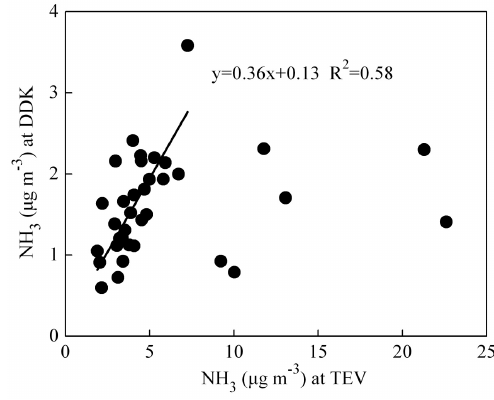
Fig. 6. Correlation of NH 3 between sites TEV and